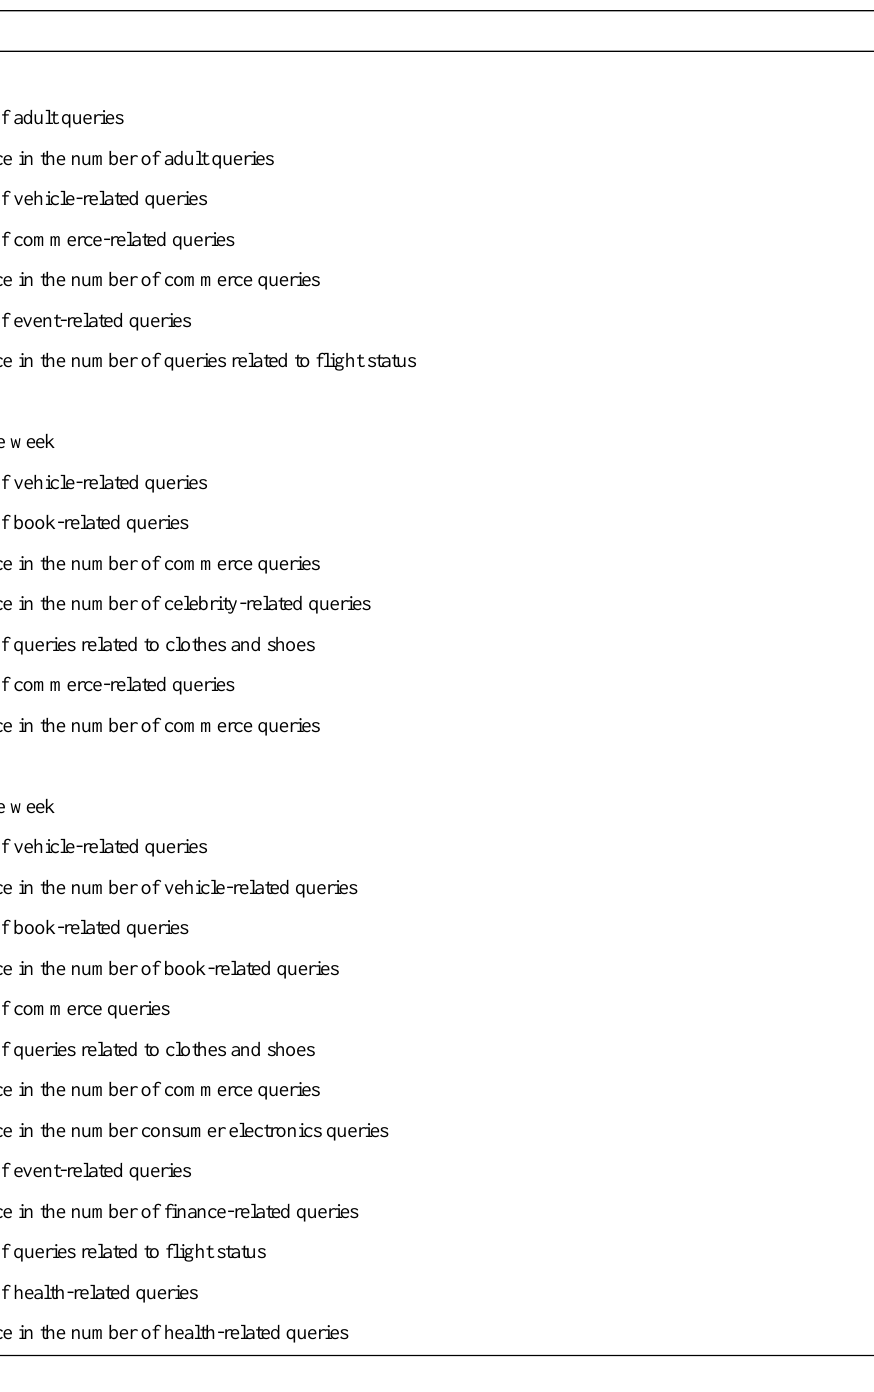
Table 4. Most frequently selected attributes for each class of